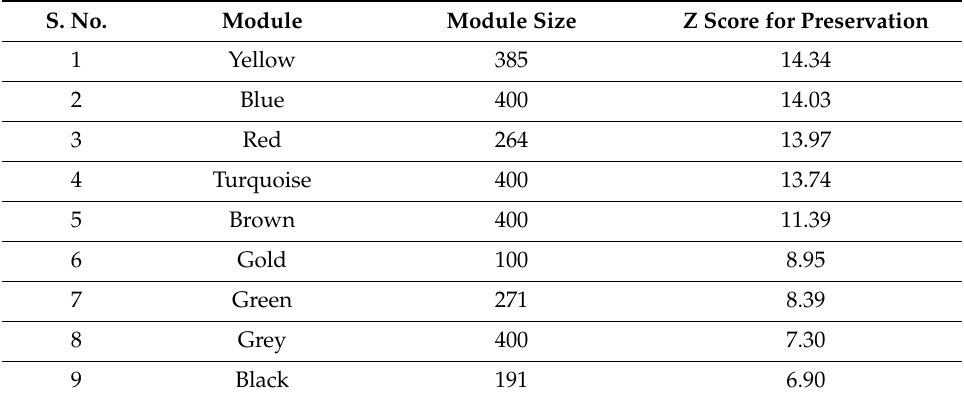
Table 13. Module preservation summary between visceral and subcutaneous datasets. S. No. Module